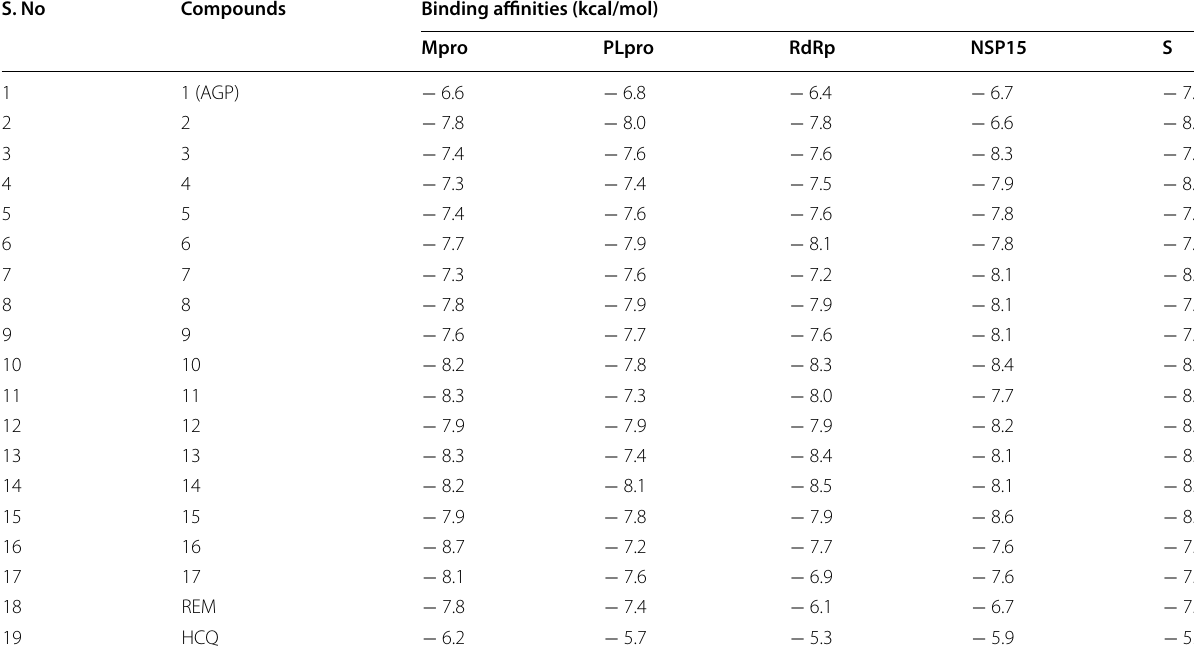
AGP andrographolide, REM remdesivir, HCQ hydroxychloroquine